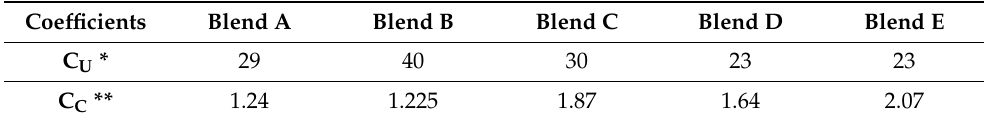
Table 2. Coefficients C U and C C .